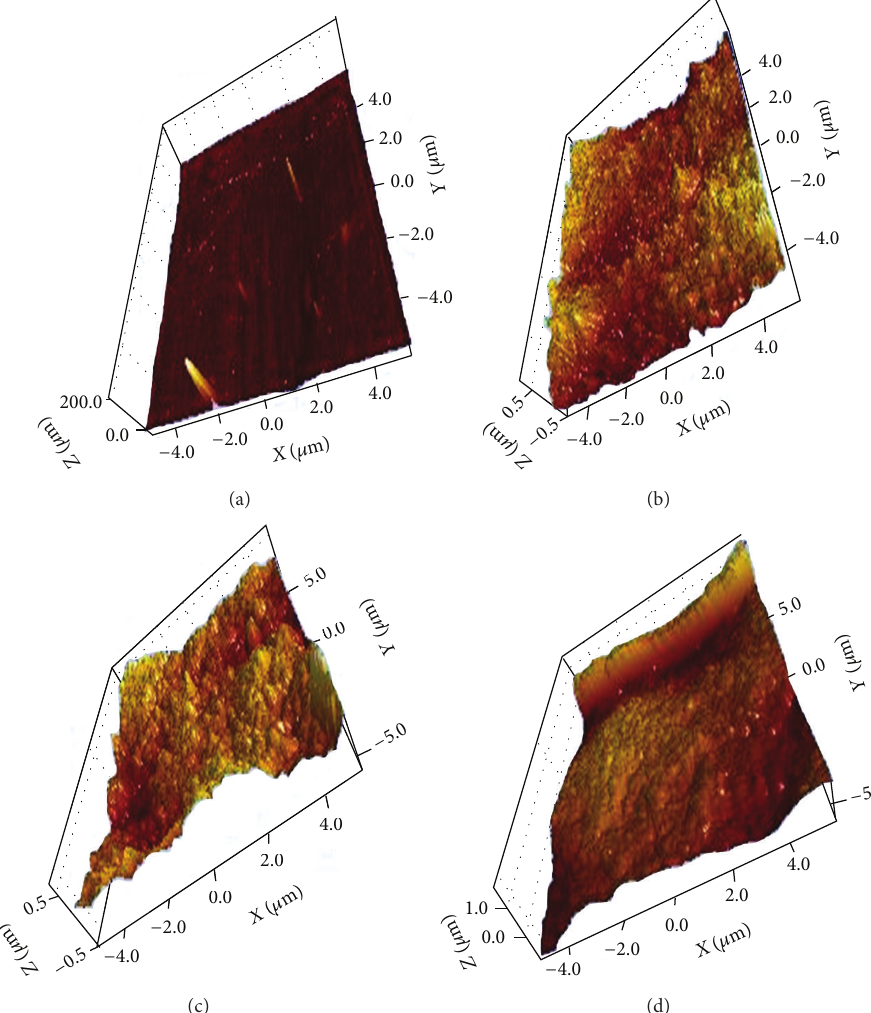
Figure 5: AFM-3D images of the carbon plate as model electrode (a), MWNT-modified electrode (b), COOH/MWNT-modified electrode (c), and AChE-ChOx/COOH/MWNT-modified electrode